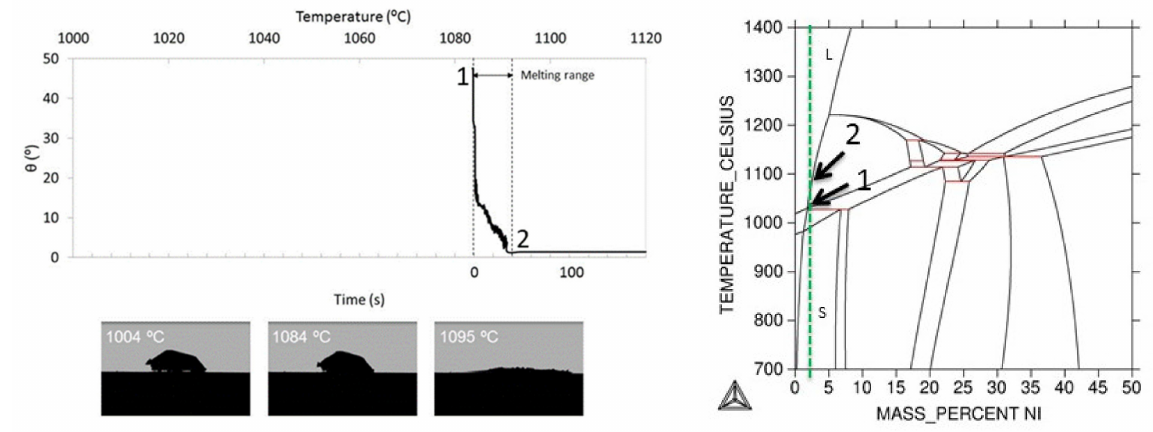
Figure 16. Relation between wetting experiments and phase diagrams. Left : Evolution of the contact angle on a dense Fe substrate in an Ar atmosphere. Right : Phase diagram (obtained with ThermoCalc ® and the SSOL5